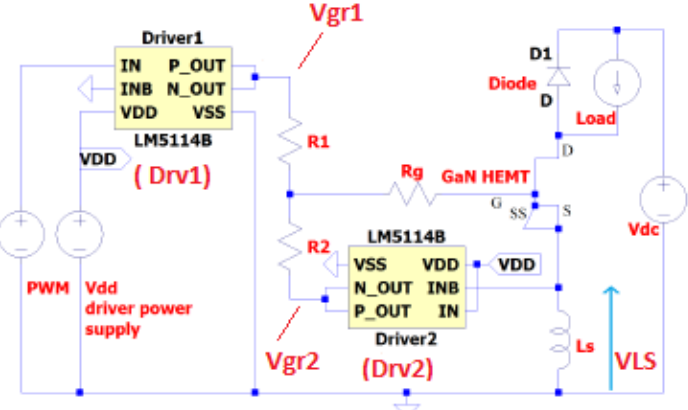
Figure 12. Schematic diagram of the proposed closed-loop AGVC using a common source parasitic inductance (L s ).